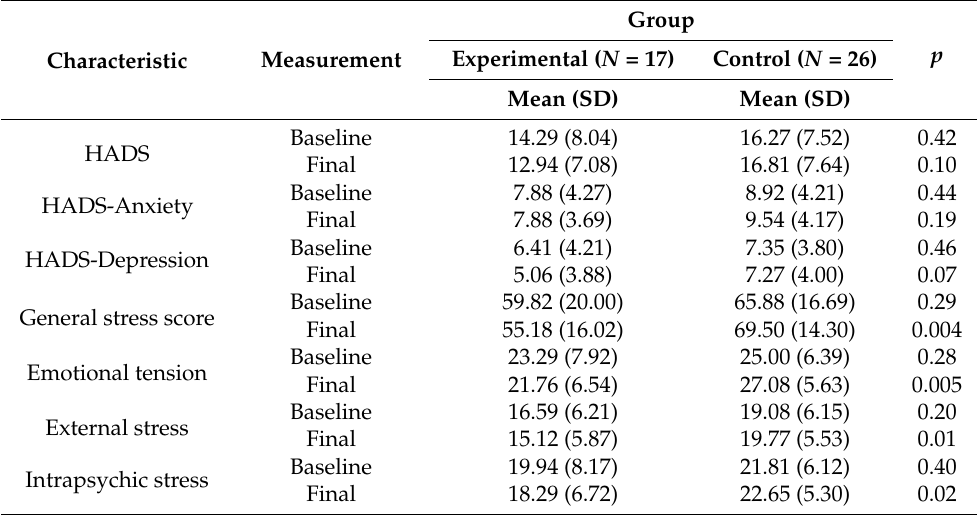
Table 2. Comparison of mental status in the experimental and control group before and after